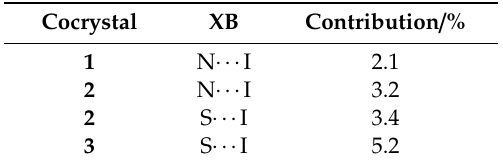
Table 4. Contributions of XBs to Hirshfeld surfaces in